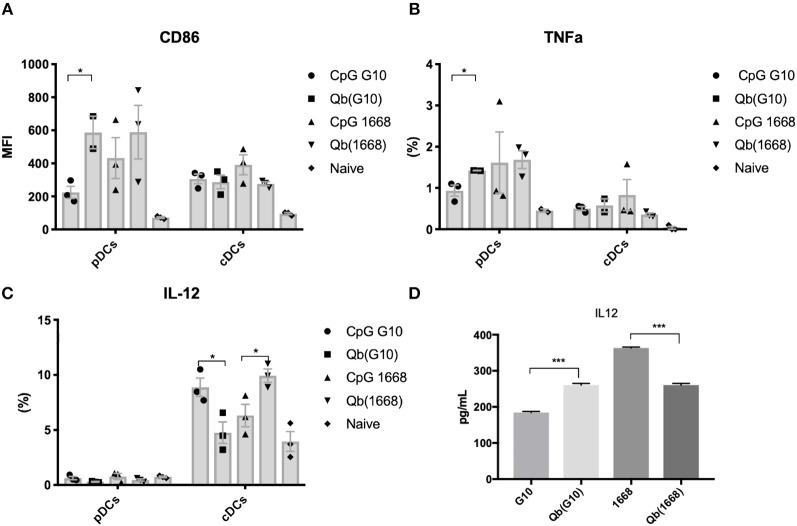
Packaging of CpGs on VLP alters the immune response induced by VLPs. (A) CD86 expression and (B) TNF-α production by splenic pDCs and cDCs. (C) IL-12 production by splenic cDCs (CD11c+CD317-) and pDCs (CD11c+CD317+) treated with 1 μM of the respective CpG or 100 μg/mL of VLP for 24 h. (D) IL-12 production by murine splenocytes incubated with either 1 μM of the free CpG or 100 μg/mL of the respective VLP for 24 h. Data represented as Mean + SEM, n = 3 mice for splenocytes and for BMDCs, pooled bone marrow of 2 mice with 3 biological replicates per condition. Statistical significance was measured by ANOVA followed by multiple t-tests followed by Bonferroni and Dunn's correction for multiple testing ***p < 0.001, *p < 0.01.